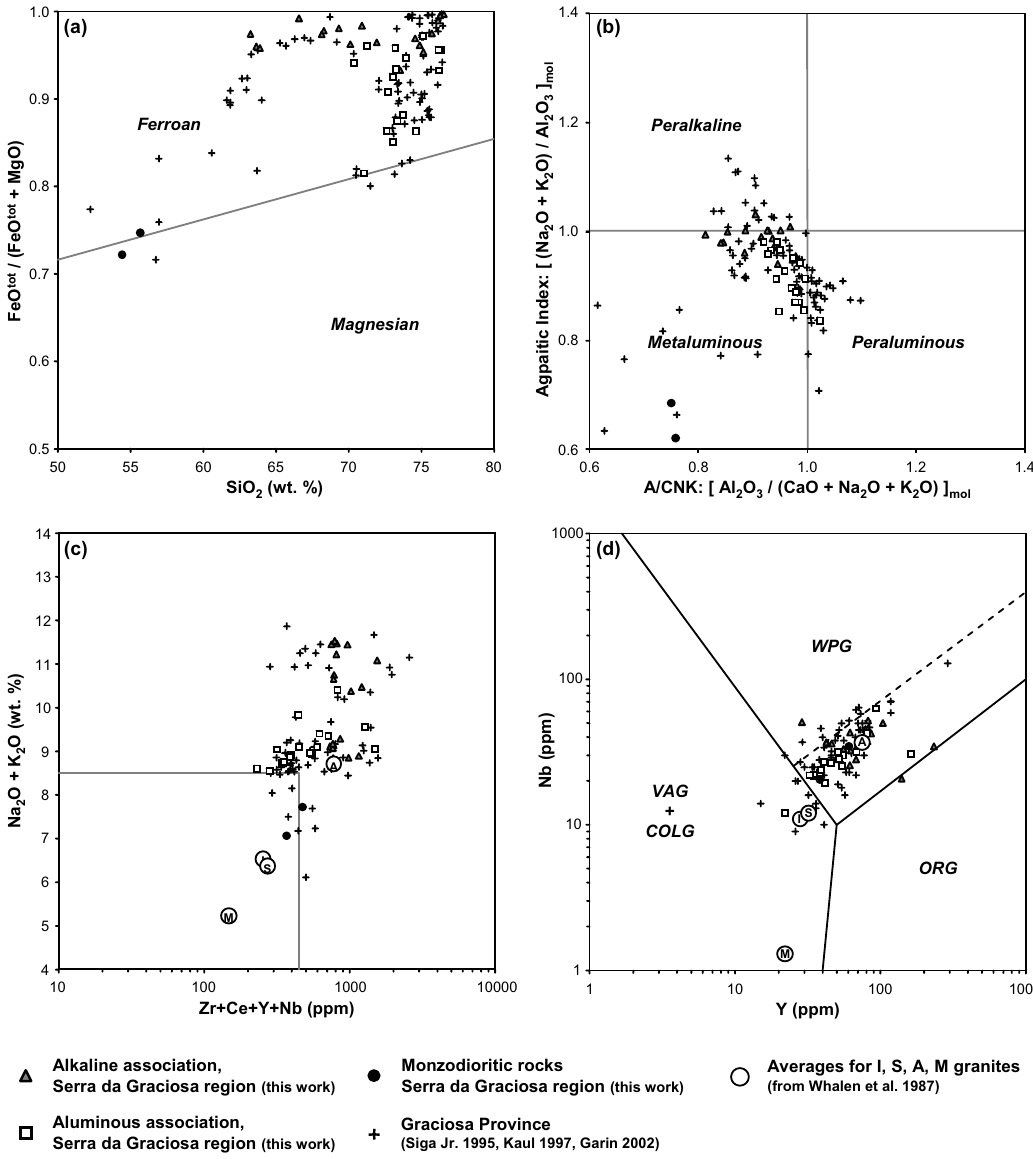
Fig. 2 – Discriminating plots for A-type granites and syenites of the Serra da Graciosa region. (a) SiO 2 versus FeO tot / (FeO tot + MgO) wt.% plot showing the ferroan character of the A-type rocks of the Graciosa Province, in agreement with what is observed elsewhere (see Frost et al. 2001). Notice the distinct trends for the alkaline and aluminous associations. (b) A/CNK versus Agpaitic Index plot showing the degree of alumina saturation. Rocks from the aluminous association are metaluminous to weakly peraluminous, while rocks from the alkaline association are metaluminous to peralkaline. (c) Na 2 O + K 2 O (wt.%) versus Zr + Ce + Y + Nb (ppm) plot discriminating A-type granites from other types of granites (I, S, and M-type). Field separating A-type granites from the remainder, as well as average compositions for all 4 types of granites, are from Whalen et al. (1987). As expected, rocks from the alkaline association show significantly higher alkali concentrations. (d) Nb versus Y plot for classification in terms of tectonic environment (after Pearce et al. 1984). Most samples fall within the field of within-plate granites (WPG), with only occasional analyses plotting in the other fields (VAG: volcanic arc granites, COLG: collisional granites, ORG: orogenic granites). Field boundaries are from Pearce et al. (1984), and average compositions for A, I, S, and M-type granites are from Whalen et al.